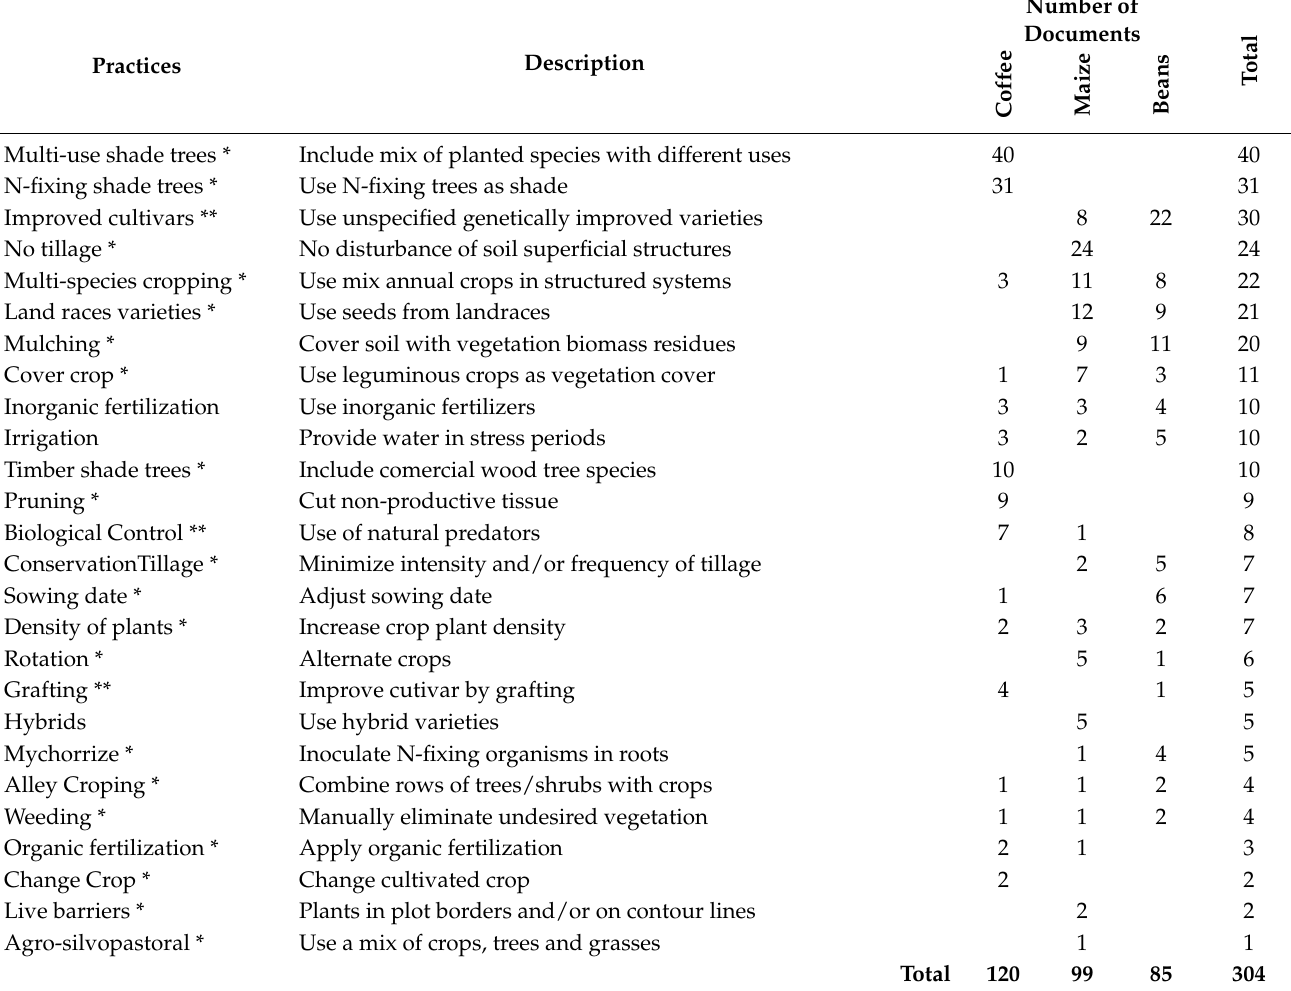
Table 1. Total number of documents retrieved and analyzed by practice and crop